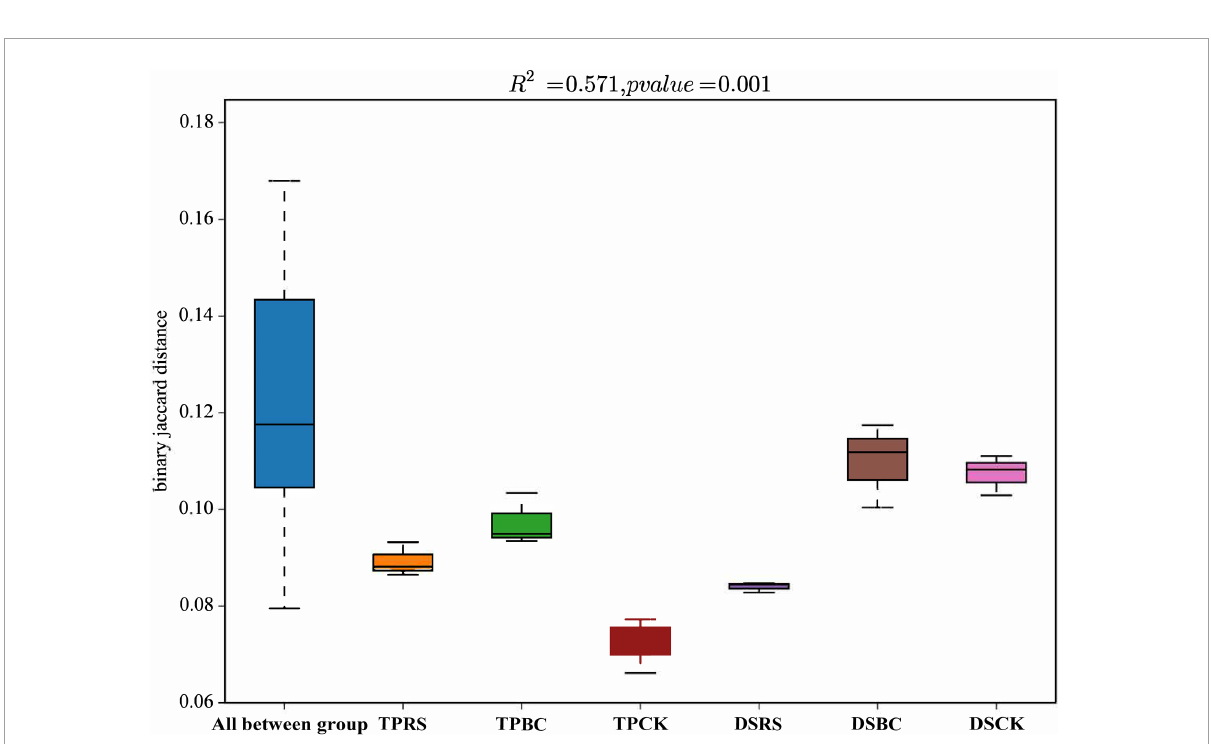
FIGURE3 Dissimilarity distances showing the differences in bacterial communities in rhizosphere soil. Dissimilarity distances were based on the Jaccard distance algorithm at the OTU level. TP, transplanting; DS, direct seeding; RS, rice straw, BC, biochar; CK, no RS or